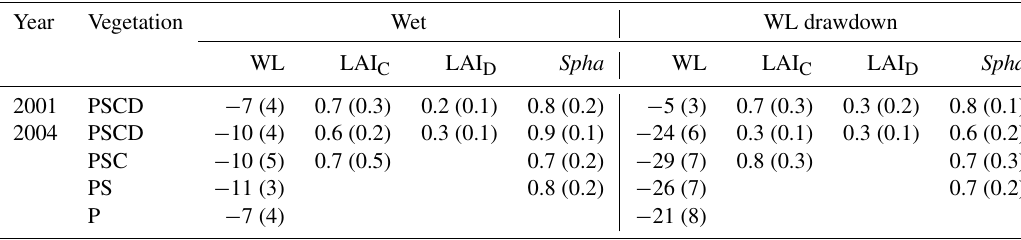
Table 1. Growing season average (standard deviation) water level (WL) relative to moss surface (in centimeters), with negative values indicating water level below the surface, growing season peak LAI of sedges (LAI C ) and dwarf shrubs (LAI D ), and projection cover of Sphagnum mosses (Spha) (unit is square meters per square meter) in different plant removal treatments in wet and WL drawdown subsites. The year 2001 was a calibration year without the WL drawdown and plant removal treatments, which were implemented in 2002. Vegetation treatments: PSCD – plots with intact vegetation, consisting of peat, Sphagnum mosses, sedges, and shrubs; PSC – plots consisting of peat, Sphagnum mosses, and sedges (shrubs removed); PS – plots consisting of peat and Sphagnum mosses (shrubs and sedges removed); P – plots consisting of bare peat (all vegetation